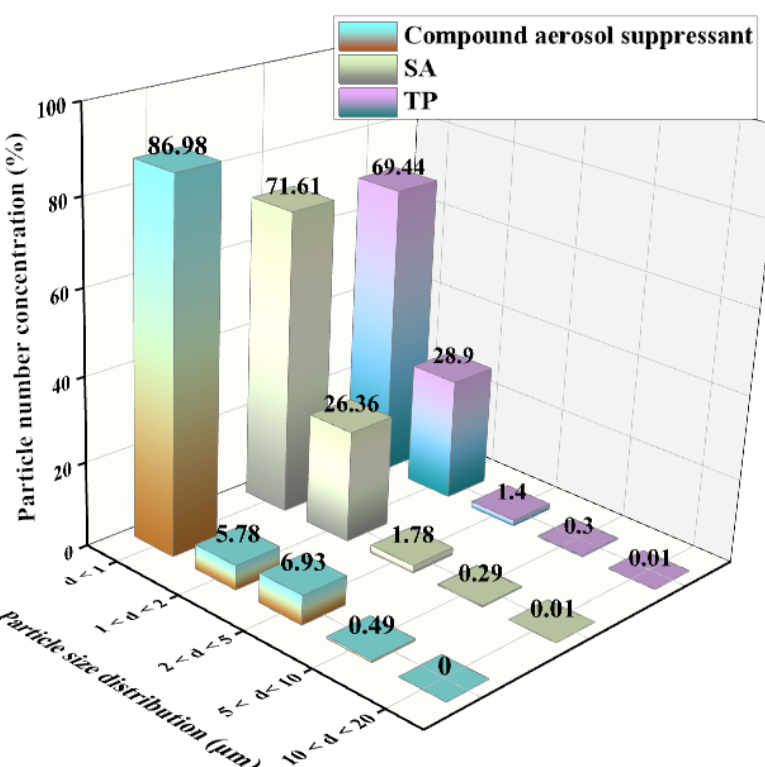
Figure 6. Particle size distribution of different aerosol suppressants after spraying into the sedimentation chamber.